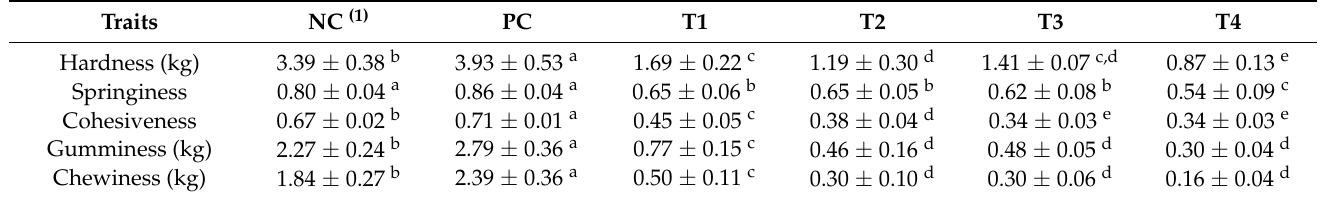
Table 5. Effects of grafted insect protein and eggshell powder on texture profile analysis of phosphate free meat